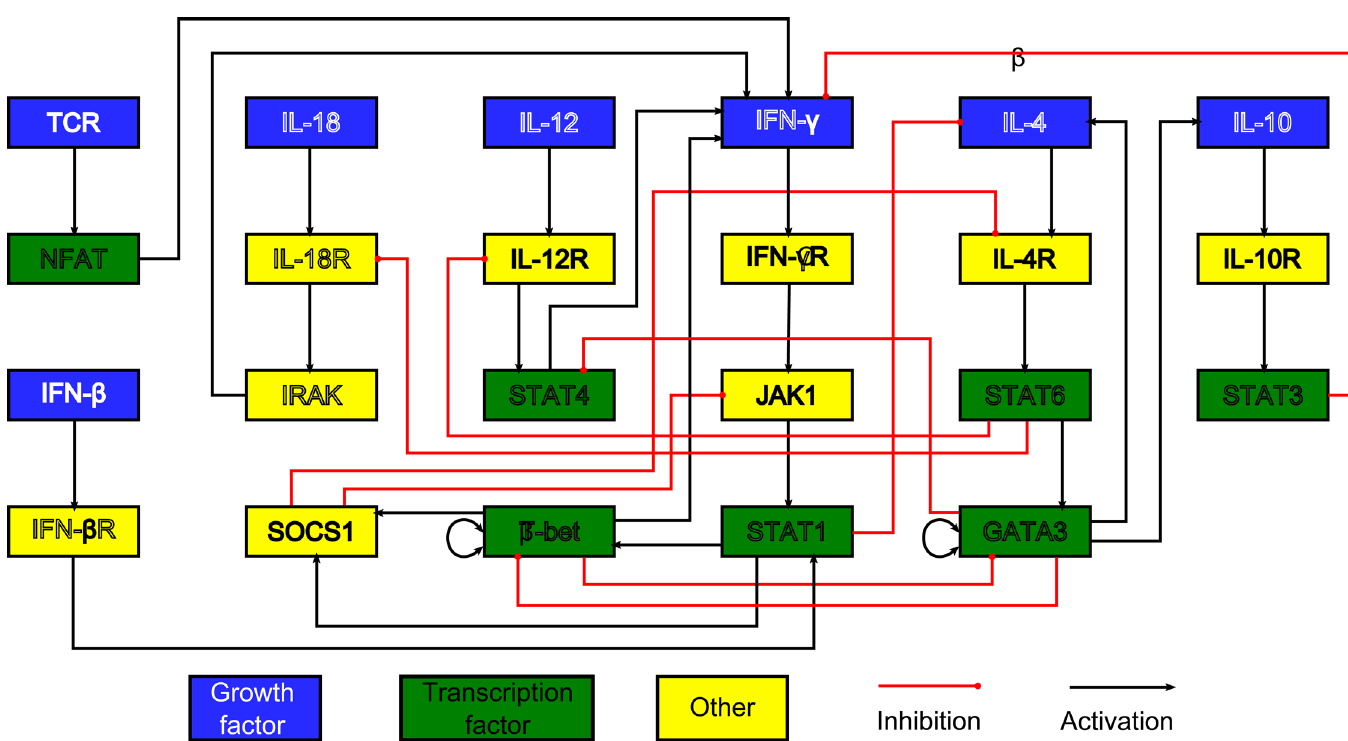
Fig 2. The T helper cell network. Every box represents a gene and its protein. The interactions are represented by red and black lines if they are inhibitory and stimulatory, respectively. Blue boxes denote growth factors, green boxes are transcription factors, yellow boxes do not belong to either category. Based on